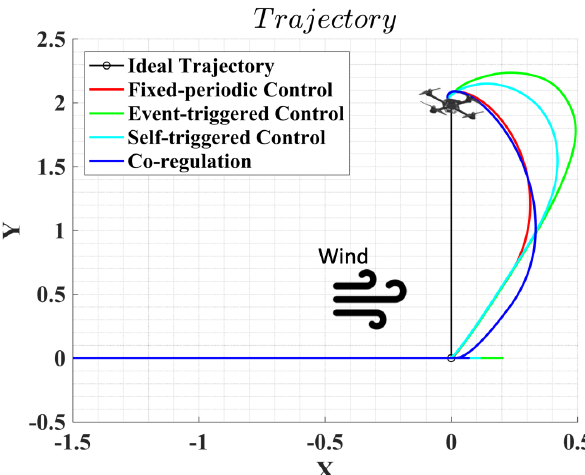
Figure 6. Waypoint following performance under